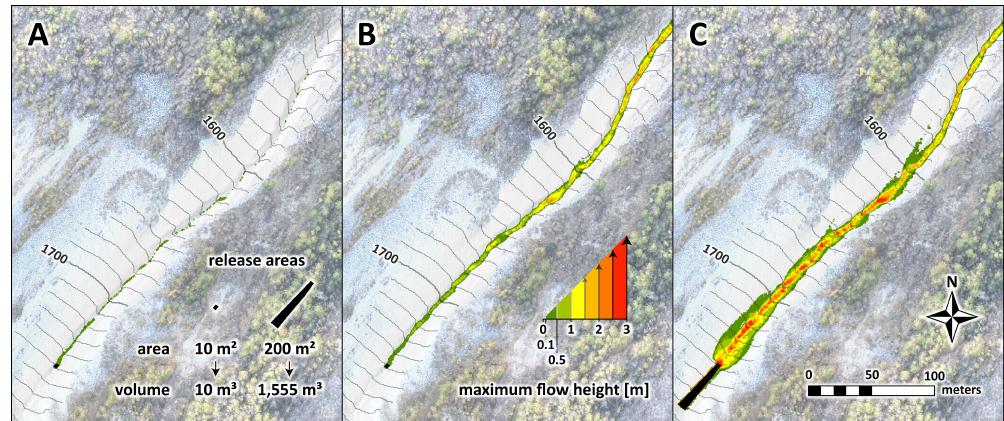
Figure 6. Comparison of runout patterns at “Bochtür” in the Meretschti catchment. The debris-flow modeling is conducted using a (subtract) block release volume of (a) 10m 3 , no-entrainment modeling of (b) 10m 3 , and entrainment modeling as well as a total (subtract) block release volume of (c) 1555m 3 (sum of release and eroded volume from (b) and no-entrainment modeling).